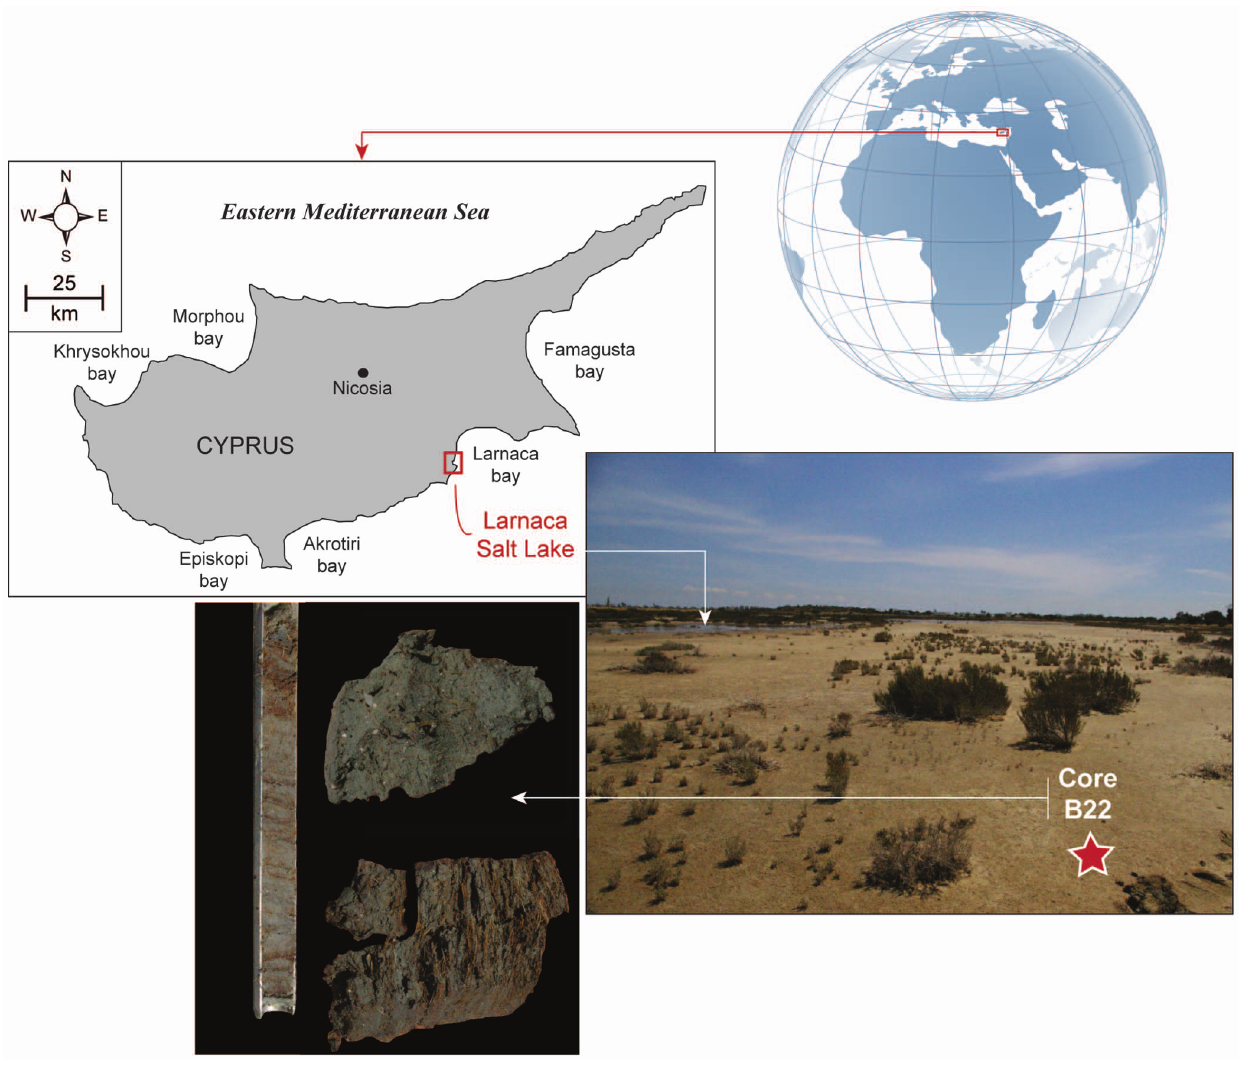
Figure 1. Map of Cyprus with an overview of the Larnaca Salt Lake (Hala Sultan Tekke) in the Larnaca Bay. Core B 22 is indicated by a red star in the modern salty area. High concentrations of Posidonia oceanica fibers are highlighted in the corer, and in lower samples.